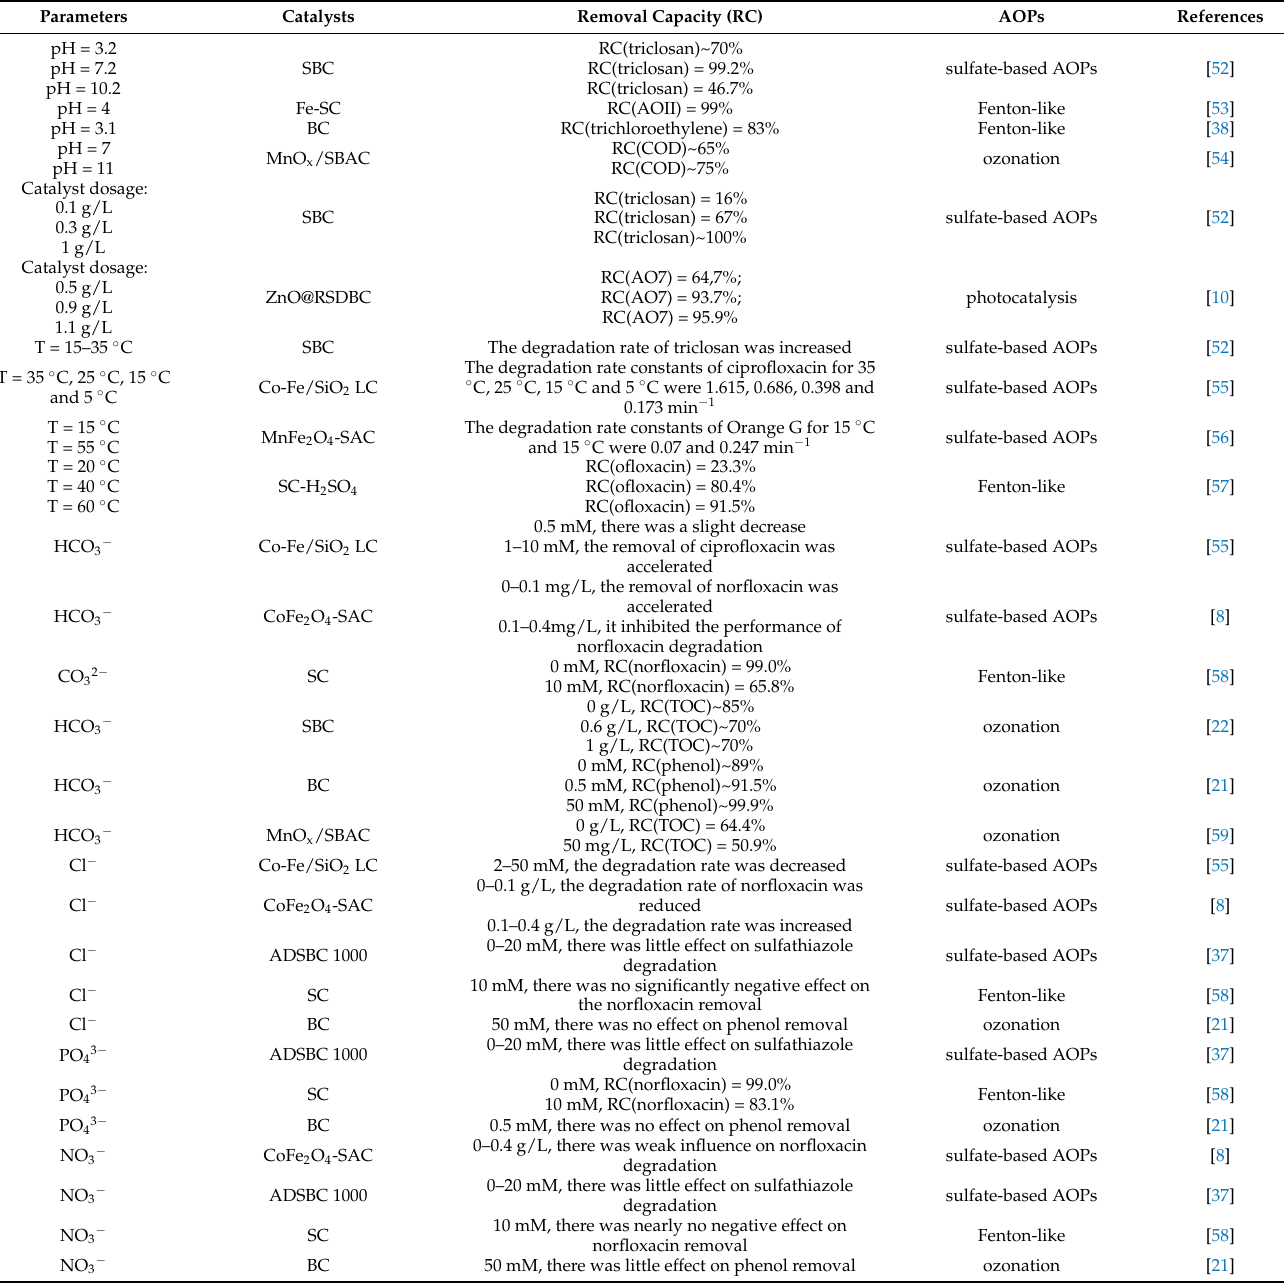
Table 1. Influence parameters in